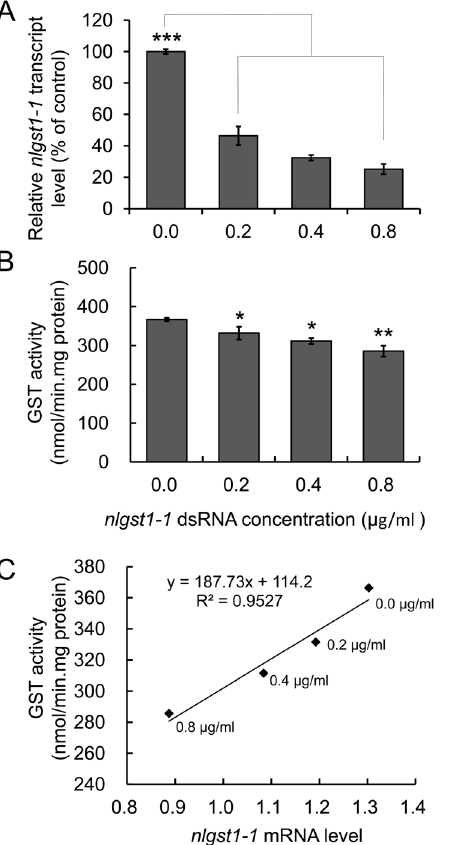
Figure 3. dsRNA-mediated invivo knockdown of GST gene nlgst1-1 and reduction of GST activities in the dsRNA-fed BPHs. BPHs were first fed on artificial diets containing 0.2, 0.4 and 0.8 m g/ml GFP- dsRNA or nlgst1-1 dsRNA for three days. Next, nlgst1-1 transcript levels in dsRNA pre-treated BPHs were monitored by quantitative real- time PCR (qRT-PCR) at 3 days post feeding. GST activities of dsRNA pre- treated BPHs were also determined by the spectrophotometric approach as described in Materials and Methods . All treatments were performed in triplicate, and the experiments were repeated three times. A . Reduction of nlgst1-1 transcript in BPHs fed on diet containing the target dsRNA. B . GST activities in BPHs fed on diets with various concentrations of target nlgst1-1 dsRNA. C. Correlation of GST activities with GST gene nlgst1-1 transcript levels in the dsRNA-fed BPHs. Data represent the means 6 SD from three independent experiments. *, **and ***indicates significance at P , 0.05, P , 0.01 and P , 0.001, respectively.